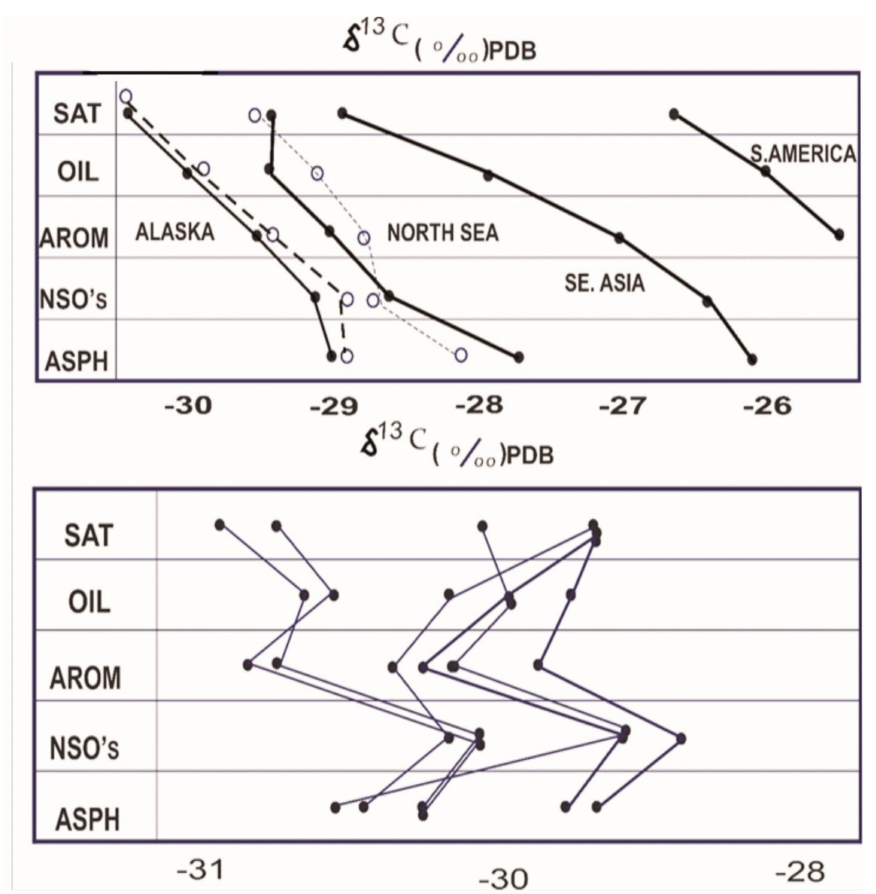
Figure 3. The isotopic relationship between the carbon isotope values of the various fractions and the source rock extracts. SAT: saturate hydrocarbons; OIL: whole oil; AROM: aromatic hydrocar- bons; NSO’s: nitrogen, sulfur, oxygen compounds; ASPH: asphaltenes (Reproduced from [50] with permission from